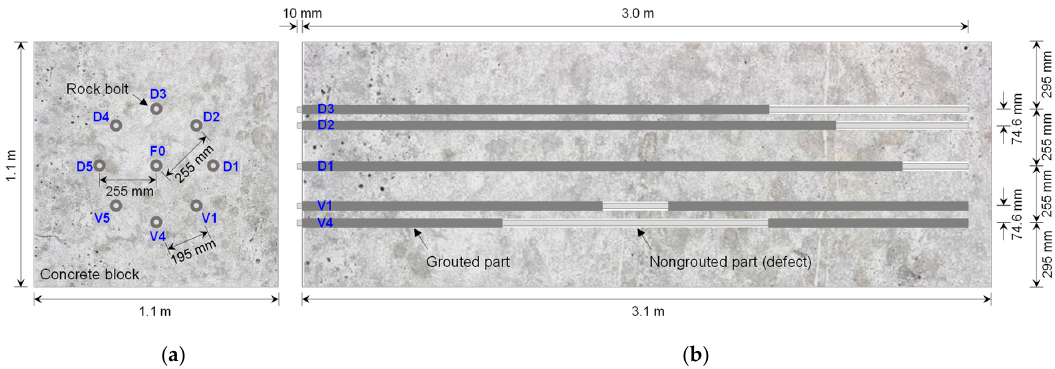
Figure 9. Diagram of concrete block with installed rock bolts: ( a ) front view; ( b ) side view.